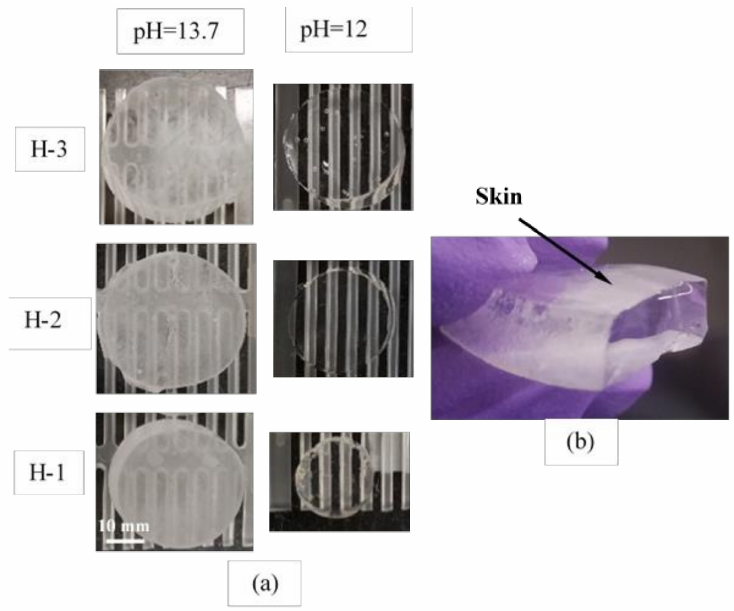
Figure 2. ( a ) Images of the hydrogel disks after absorption in synthetic pore solutions with pH = 12 and pH = 13.7. ( b ) Image showing the formation of a skin on the surface of a hydrogel disk swollen in the synthetic pore solution with pH =